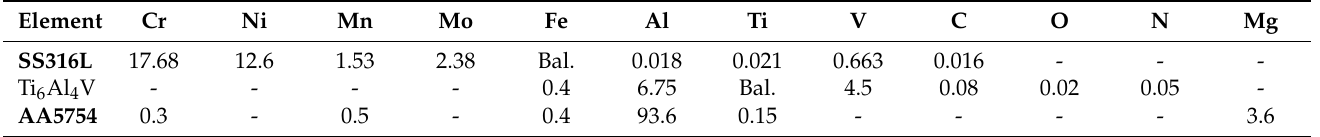
Table 1. Chemical composition of SS316L, Ti6Al4V, and AA5754 alloy (wt